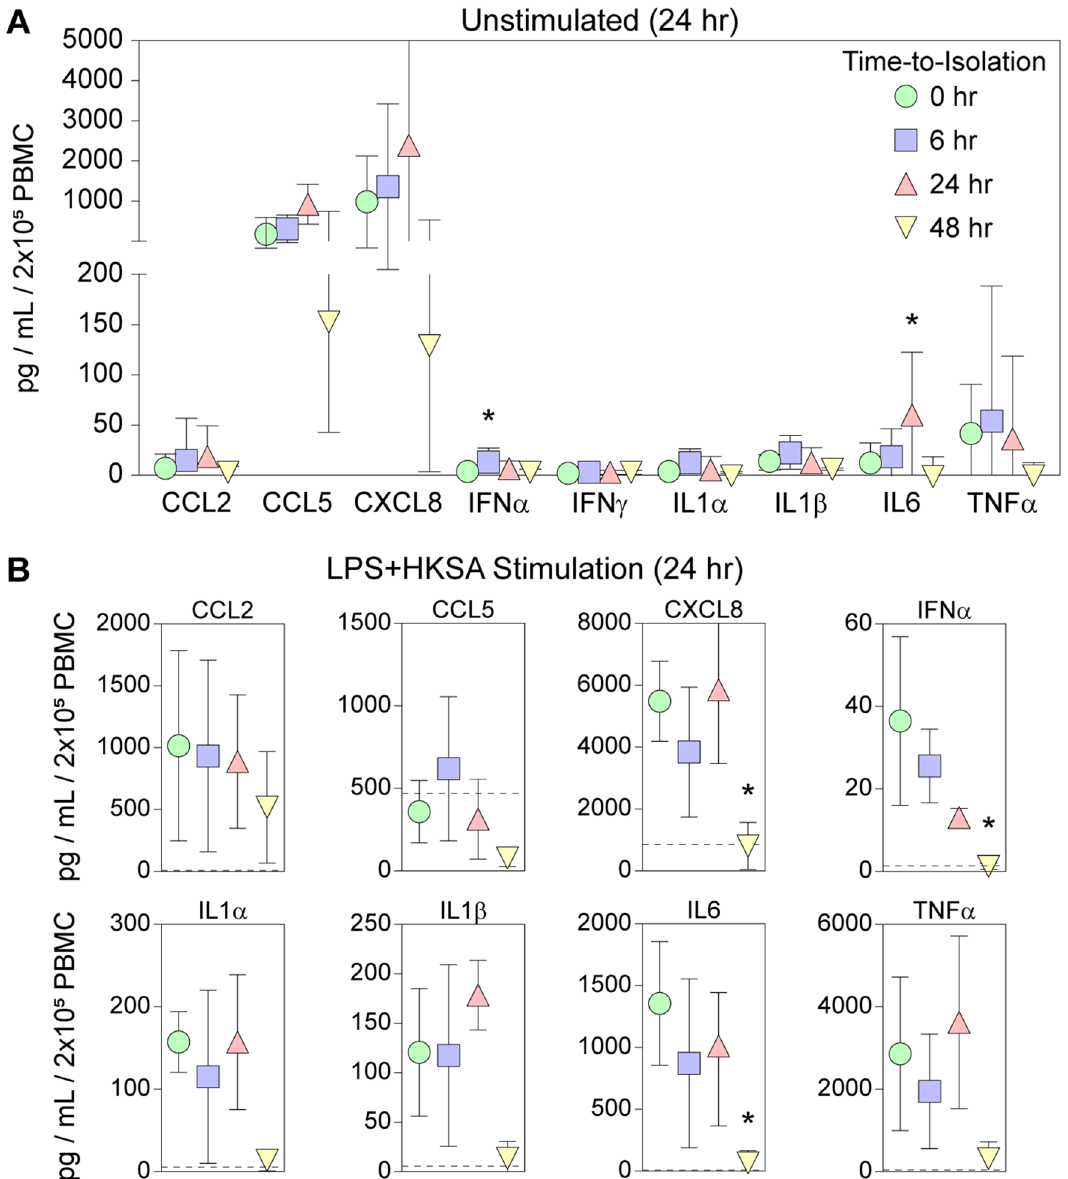
Figure 5. Spontaneous and stimulated release of inflammatory factors is maintained in PBMCs isolated from whole blood held at ambient temperature for 6 or 24 h. PBMCs isolated from blood held for 0, 6, 24, or 48 h were either incubated for 24 h in the absence of stimulation ( A ) or were incubated for 24 h with a cocktail of LPS and HKSA ( B ). Inflammatory cytokines and chemokines released into the supernatant were quantified by multiplex cytometric bead array. ( A ) Relative to PBMCs isolated from fresh blood, cells derived from blood held for 6 h at ambient temperature exhibited a small increase in spontaneous release of IFNα while cells held for 24 h released more IL6. ( B ) PBMCs from fresh blood stimulated for 24 h with LPS and HKSA released increased amounts of CCL2, CXCL8, IFNα, IL1α, IL1β, IL6, and TNFα. CCL5 release was not increased above spontaneous levels. This pattern was maintained in stimulated PBMCs isolated from blood held for 6 or 24 h at ambient temperature. However, PBMCs isolated from blood held for 48 h exhibited a uniform decrease in the stimulated response, with significant reductions in CXCL8, IFNα, and IL6 release. Symbols are color-coded as in the legend of ( A ). Analyte levels were normalized to pg per mL per 2 × 10 5 PBMCs. Dashed lines in B represent the mean spontaneous (unstimulated) release level from the 0 h samples. Each symbol represents the mean of 3 individual donors and error bars show the 95% confidence intervals. Each analyte timecourse was assessed by one-way ANOVA; * indicates P < 0.05 vs 0 h by Dunnett’s pairwise